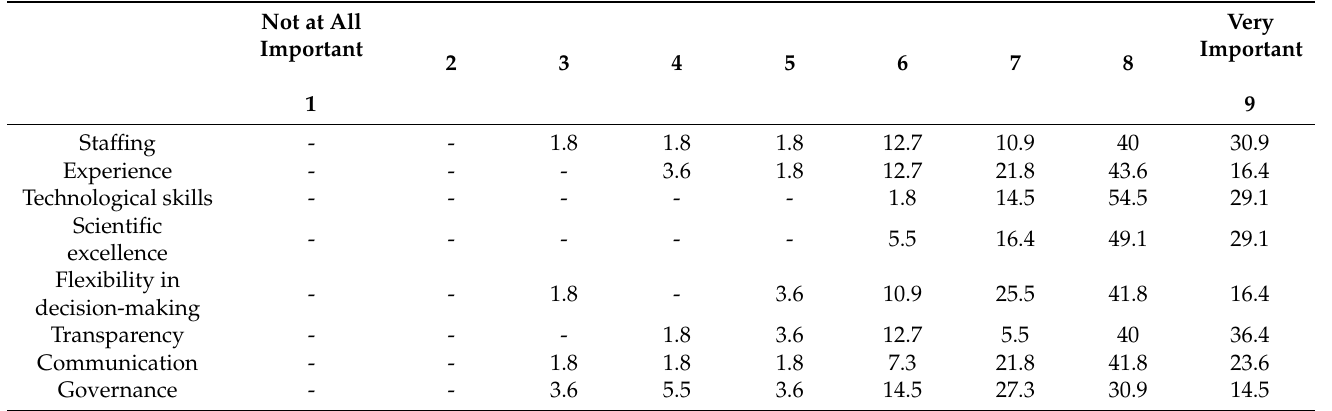
Table 4. Percentage units regarding respondents’ evaluation of the importance of various aspects in the establishment and operation of Hub ( N = 55).